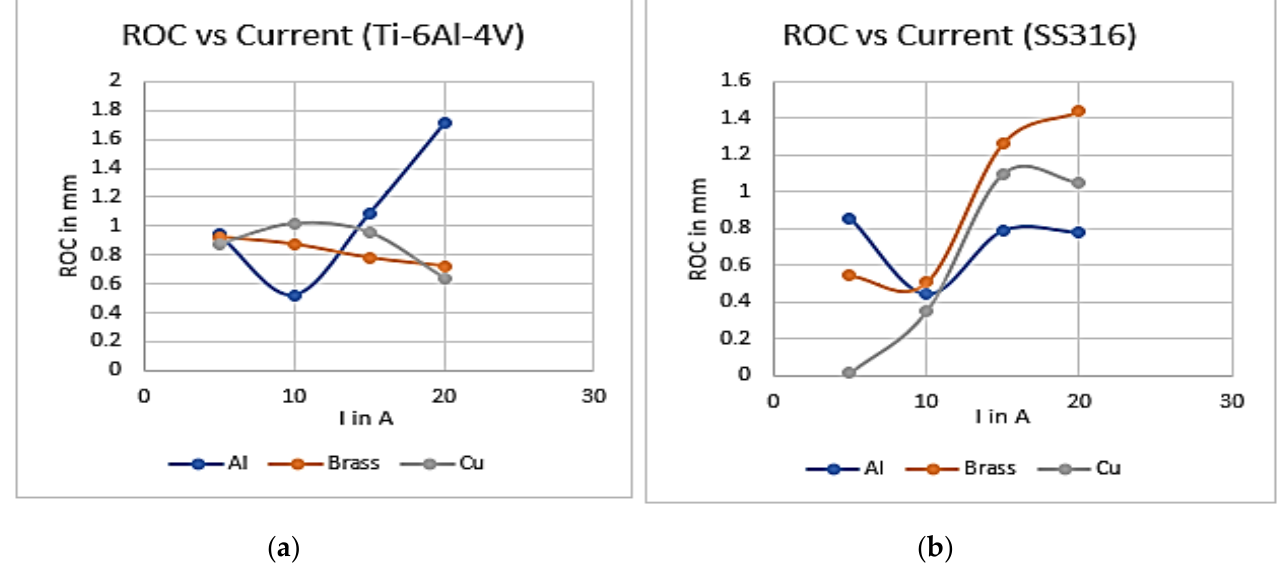
Figure 10. Variations of ROC for ( a ) Ti-6Al-4V and ( b ) SS316 using different tools.